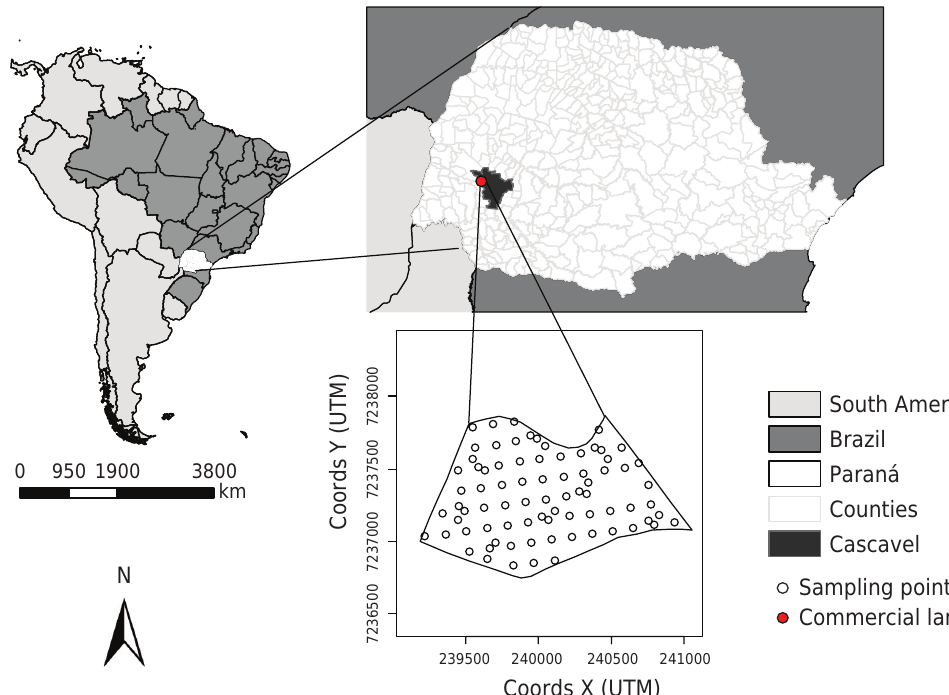
Figure 1. Location map of the study